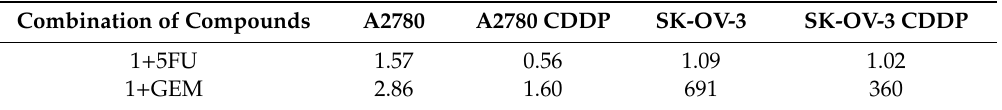
Table 2. Calculated combination index (CI) values of simultaneously delivered salinomycin ( SAL , 1 ) and cytotoxic drugs (5-fluorouracil 5FU , gemcitabine GEM ) in the 1:1 molar mixtures. Combination of Compounds